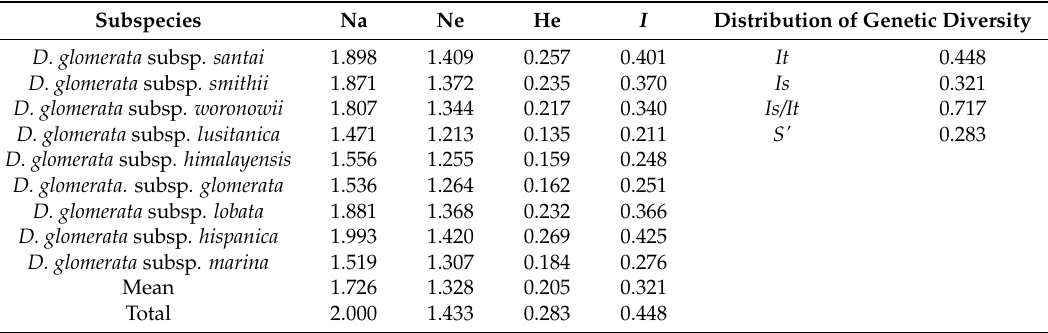
Table 3. Genetic variation statistics and Shannon’s diversity estimation for all subspecies.